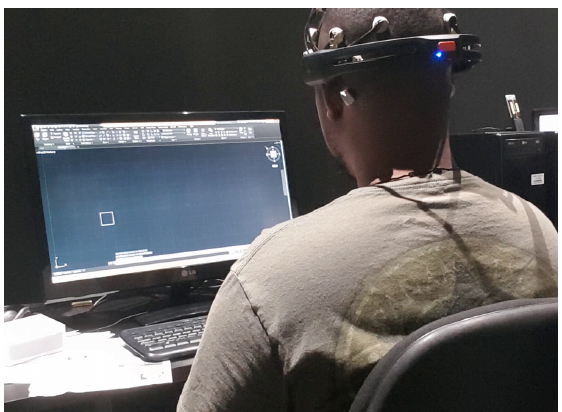
Figure 1. A subject is using AutoCAD and wearing EEG headset in real experimental